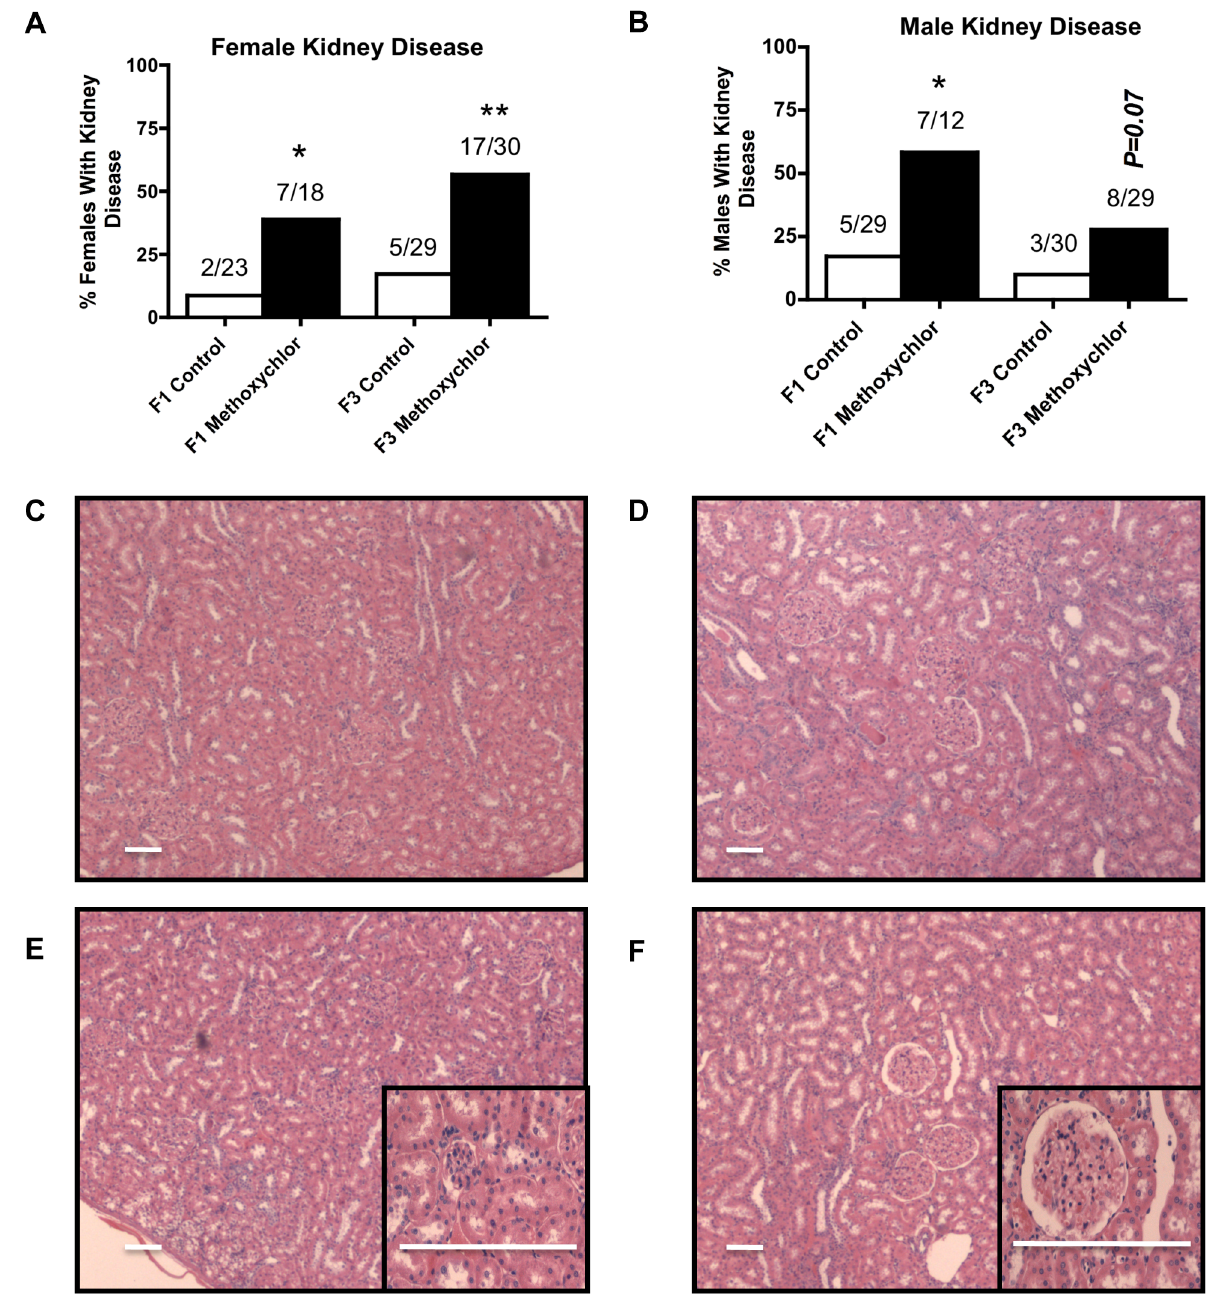
Figure 1. Ancestral exposure to methoxychlor and transgenerational kidney disease. Percentages of females (panel A, C, E) and males (panel B, D, F) with kidney diseases in the F1 and F3 generation control (open bars) and methoxychlor (black bars) lineages. The number of diseased rats / total number of rats in each lineage are also shown (* P , 0.05; ** P , 0.01).